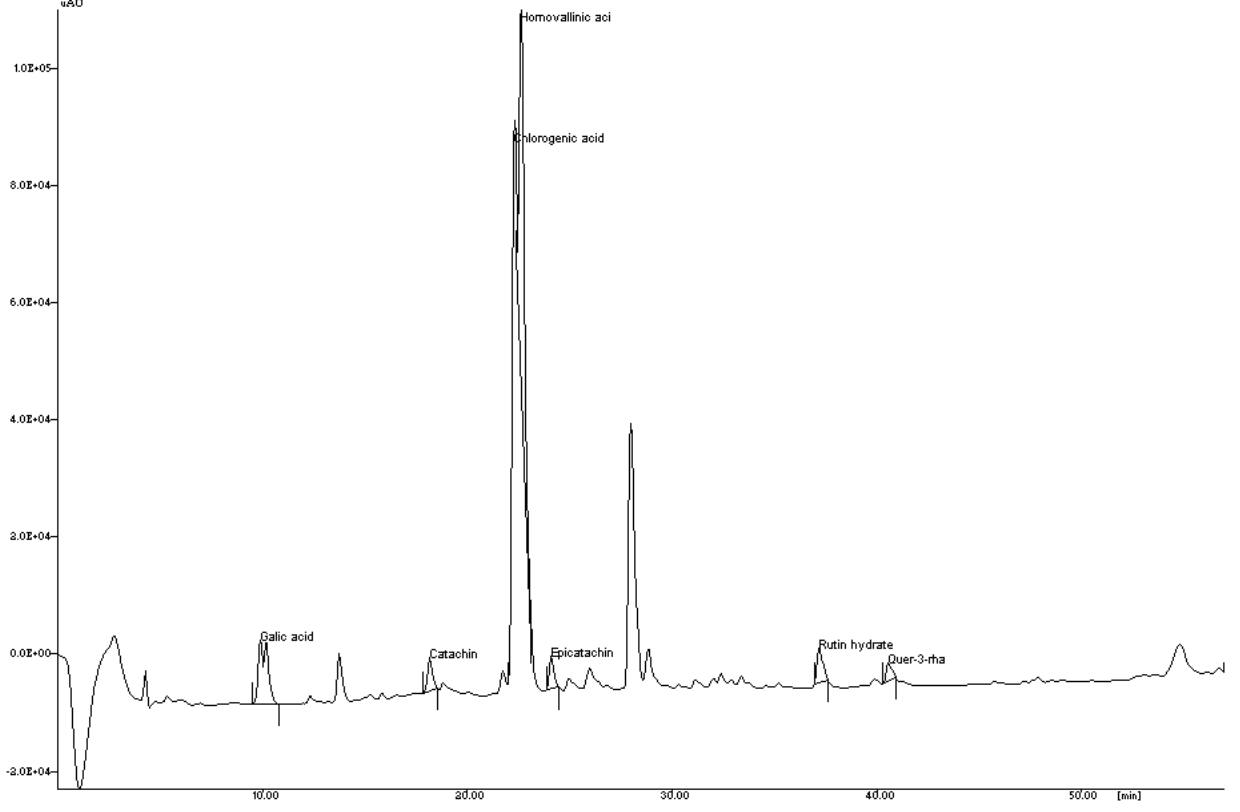
Figure 1. RP-HPLC chromatogram of the identified polyphenols in the ethanolic extract of N. jatamansi